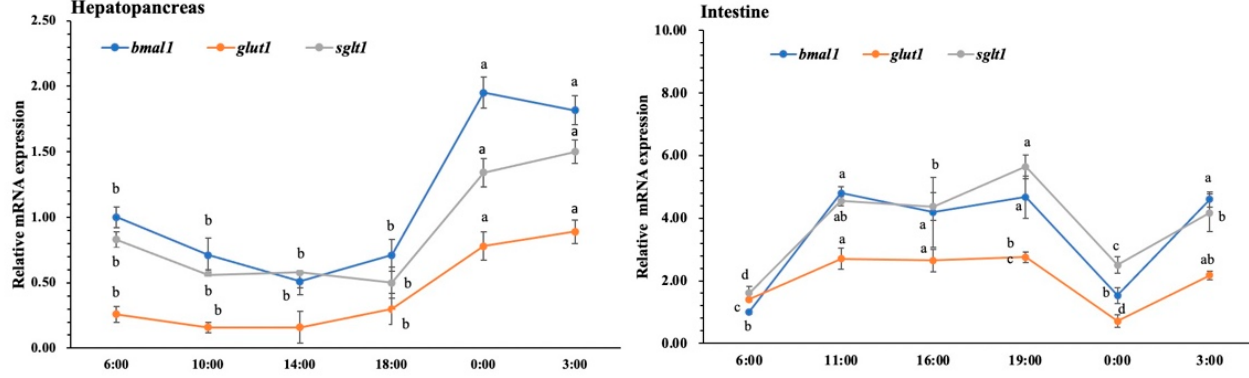
Figure 1. Daily profile of BMAL1,GLUT1 and SGLT1 expression in the intestine and hepatopancreas. Six shrimp were sampled at each time point (n = 6). Data presented are mean ± SD, and the different letters above the broken line represent significant differences between different time points ( p < 0.05).